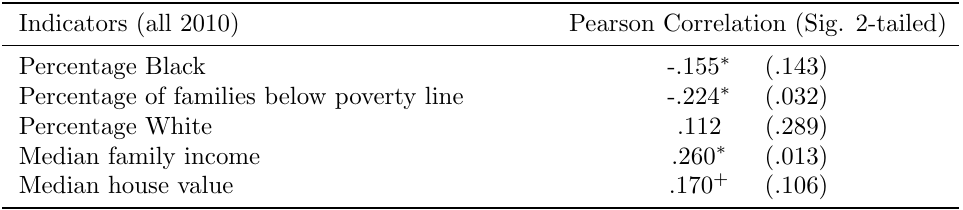
Table 5: Correlations between the LURE index and local traits Indicators (all